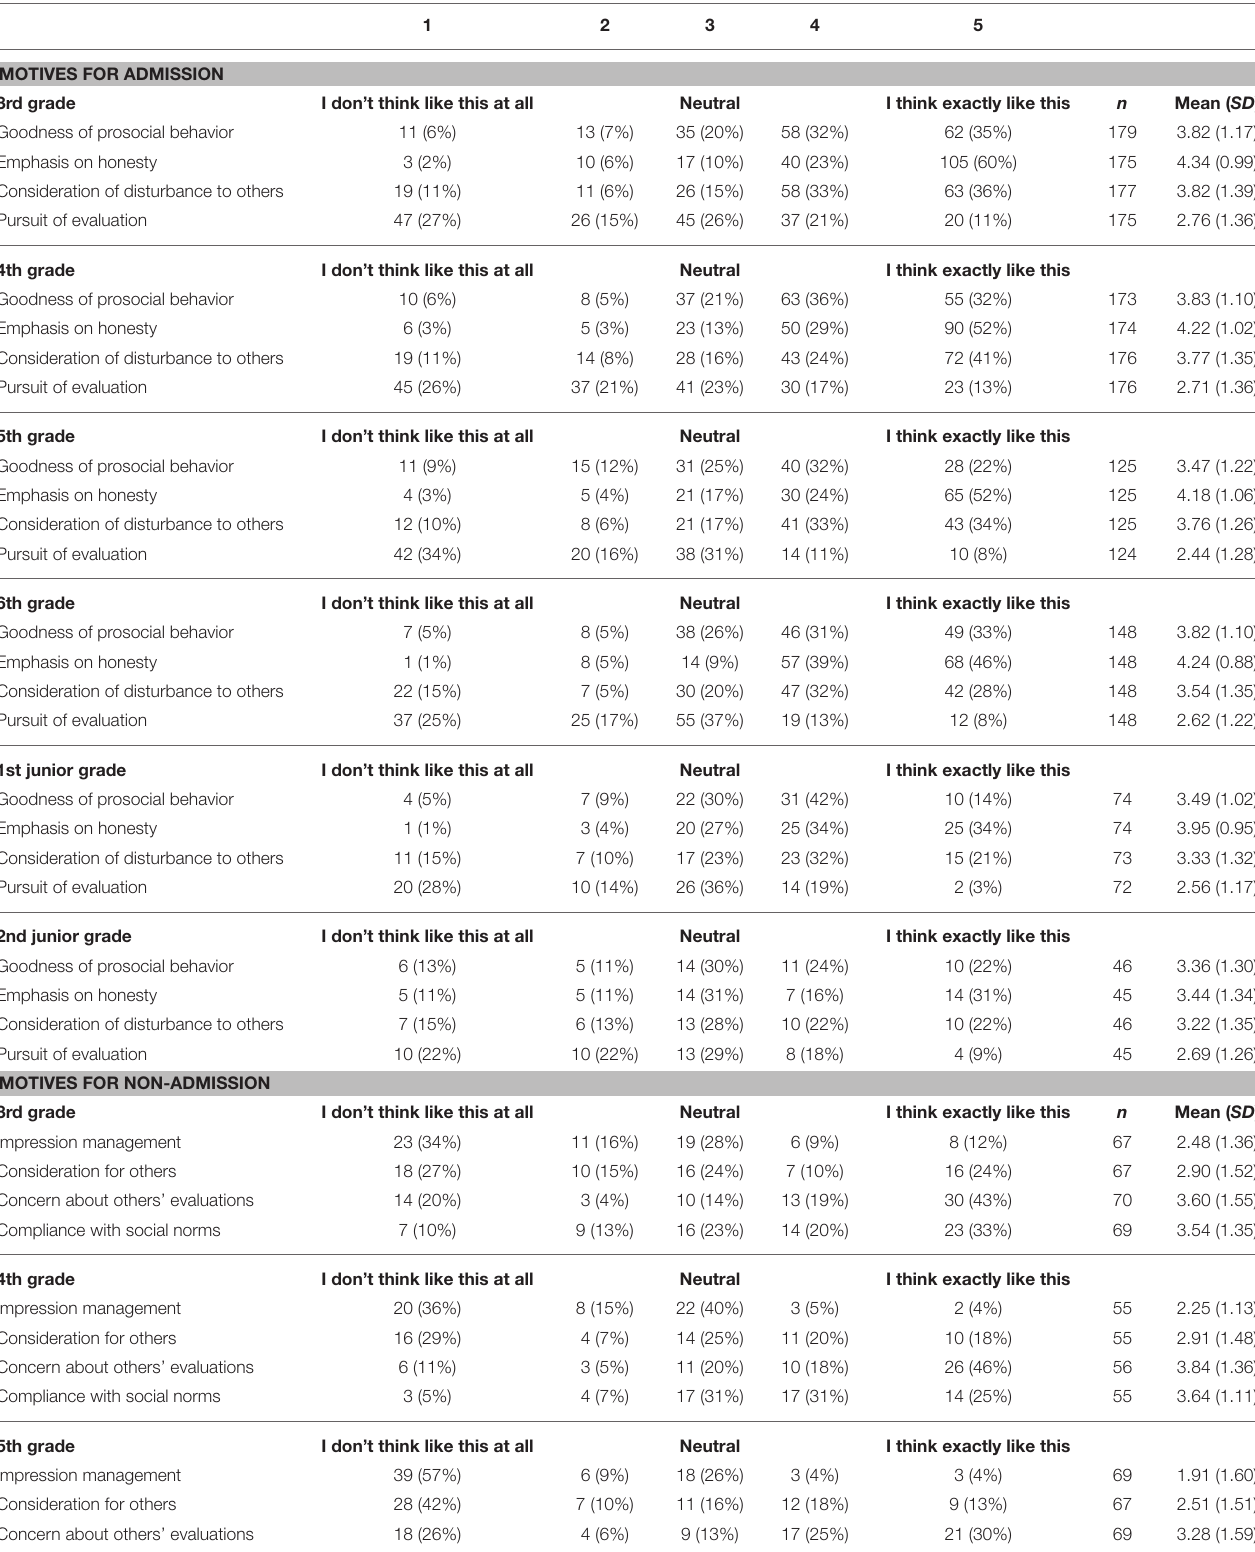
TABLE 2 | Descriptive statistics of each category in each